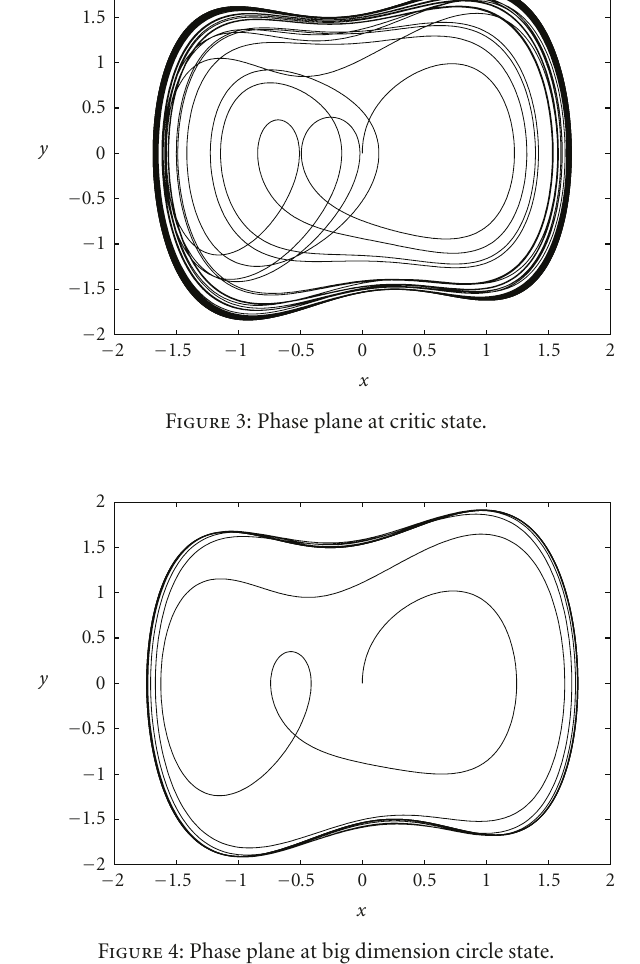
Figure 4: Phase plane at big dimension circle state.